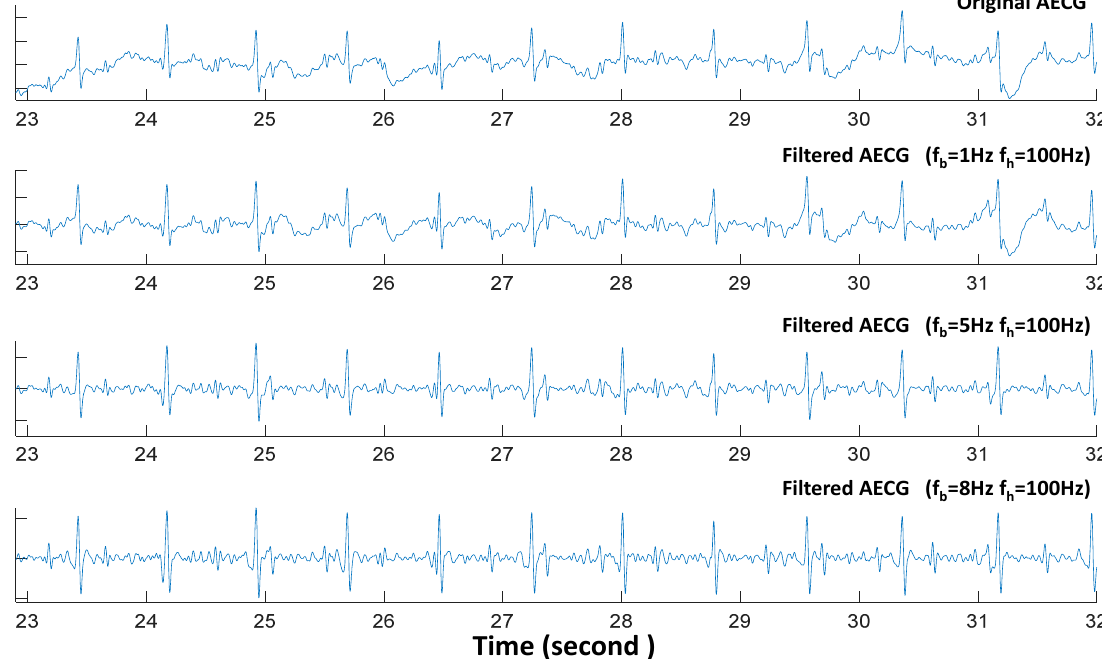
Figure 5. The different preprocessed AECG wave with different baseline cut-off frequency f b and the same high frequency f h = 100 Hz.